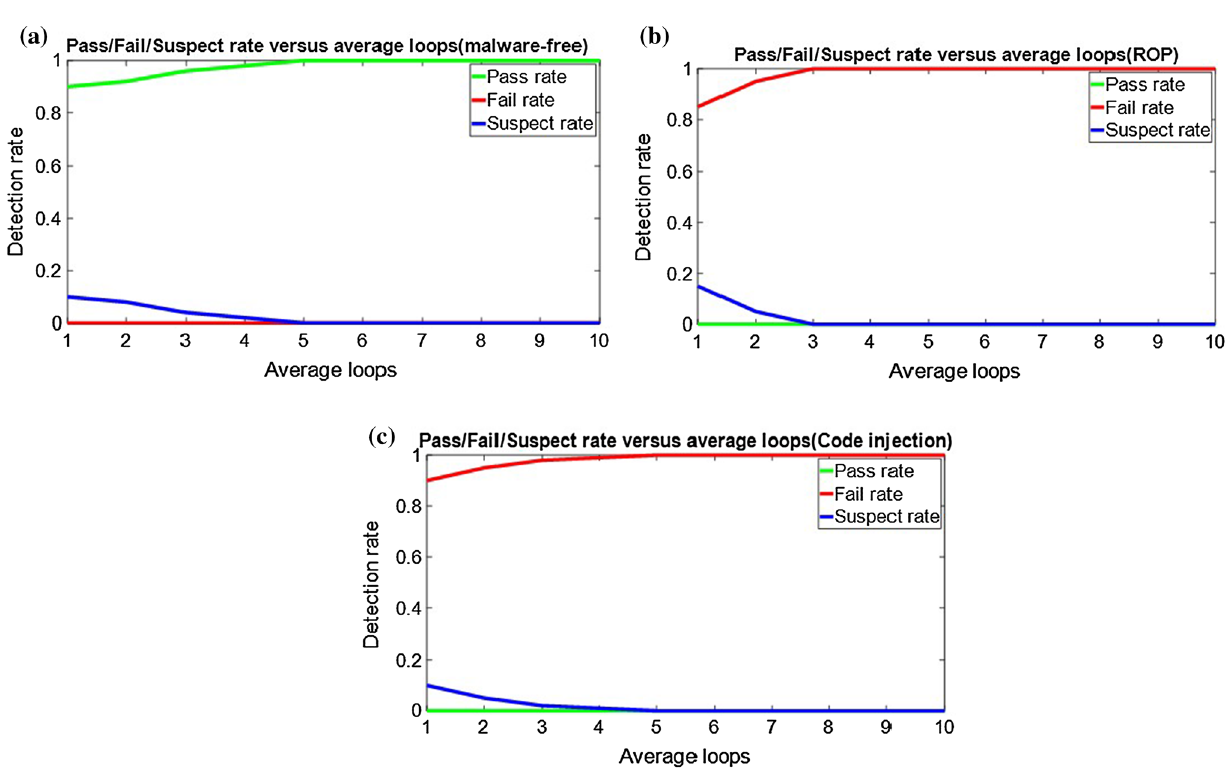
Fig. 10 Pass/fail/suspect rate versus average loops for benchmark “Matrixmultiplication” in a malware-free b ROP c code injection